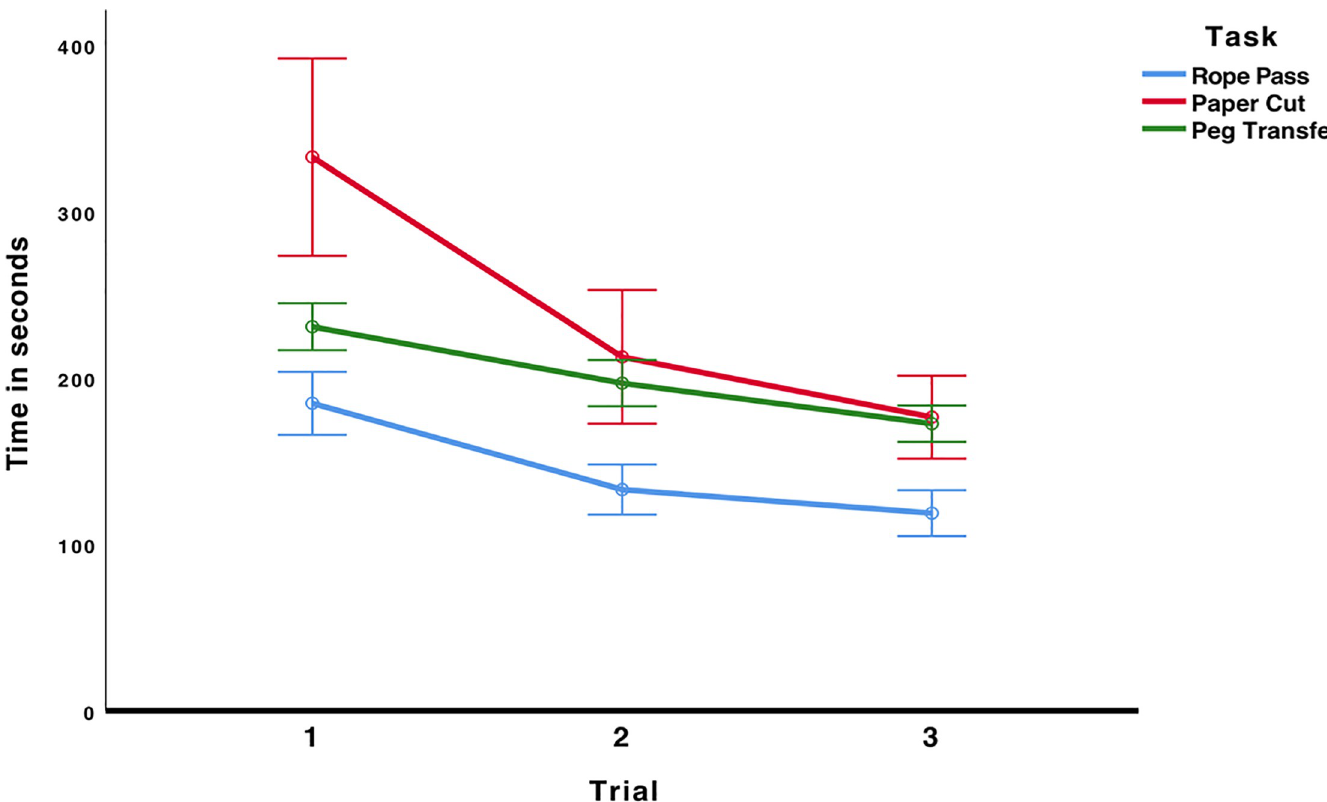
Fig 4. Time to complete each laparoscopic task. Error bars represent 95%-CI of the mean.